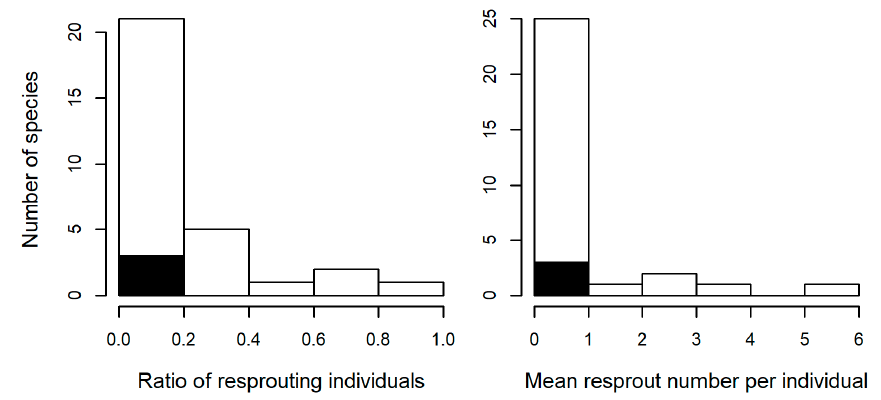
Figure 3. Frequency distribution of species (open: hardwood, closed: conifers) in terms of